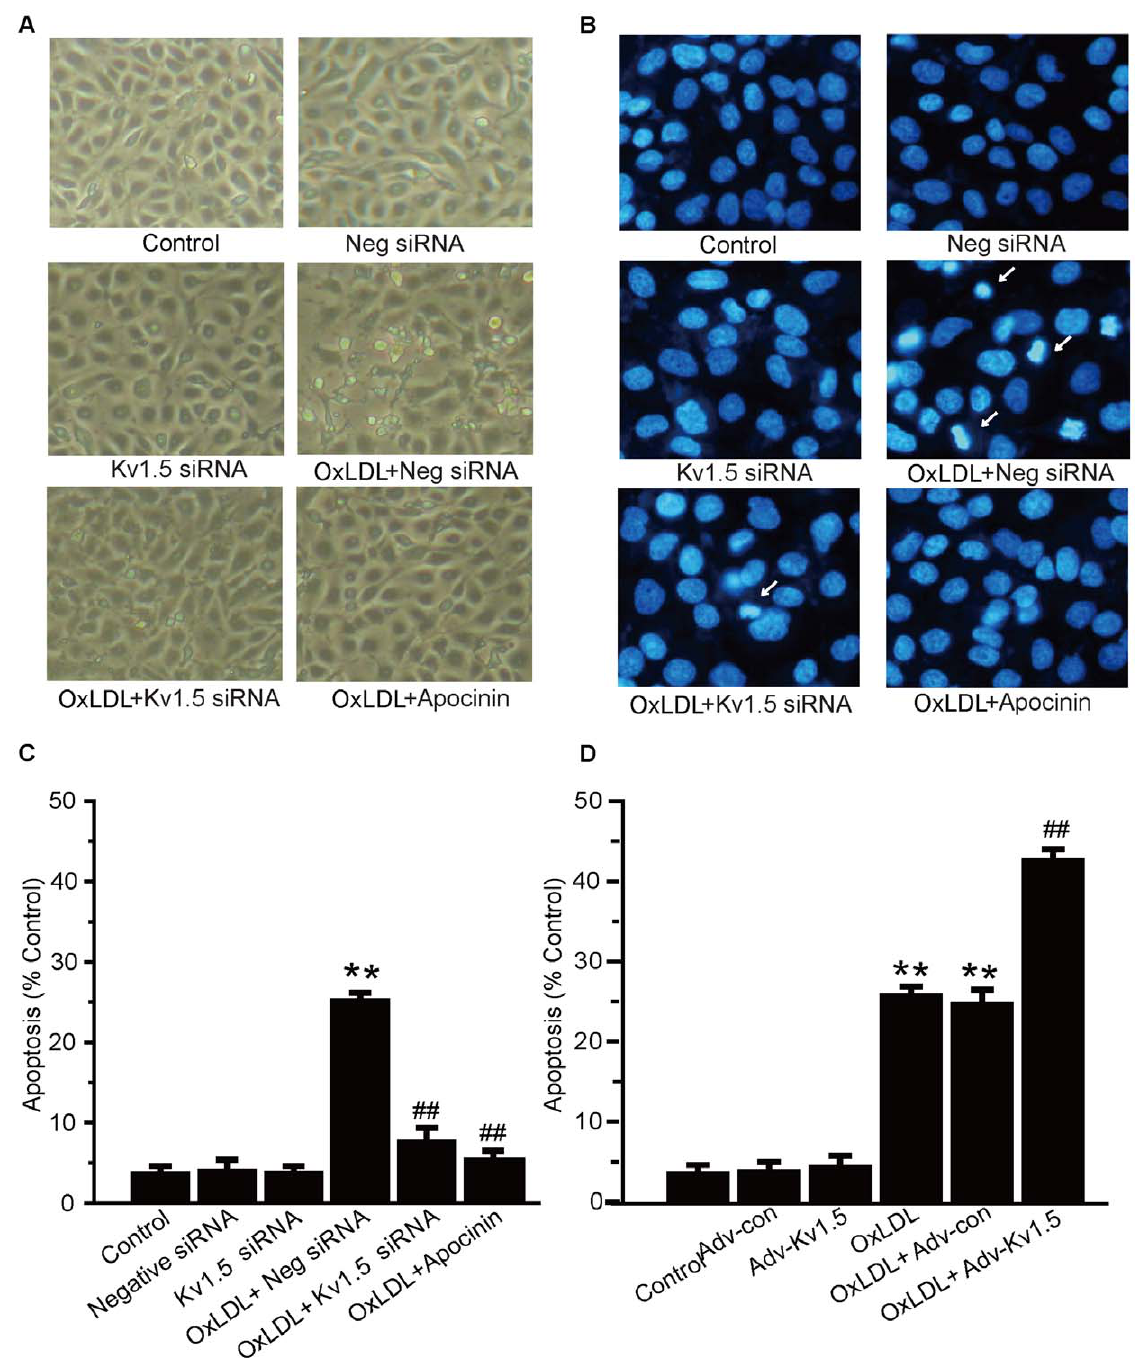
Figure 4. OxLDL-induced EC injury was attenuated by Kv1.5 siRNA, but aggravated by adnoviral Kv1.5 overexpression. HPAECs were transfected with Kv1.5 siRNA (10 nM) or control siRNA for 48 h, or infected with adnovirus containing KCNA5 and control–adnovirus for 24 h, then treated with oxLDL (150 m g/ml) for further 24 h. The oxLDL-induced EC injury was detected by optical microscopy and DAPI staining. The optical microscope observation (A) and DAPI staining (B) show the morphological changes in Kv1.5 siRNA pretreated HPAECs. The mean values of percentages of apoptotic cells were summarized after DAPI staining in Kv1.5 siRNA (C)- and KCNA5 adnovirus- pretreated (D) HPAECs. The values are presented as means 6 SEM of 6 independent experiments. * P , 0.05, ** P , 0.01 vs. Vehicle control; # P , 0.05, ## P , 0.01 vs.